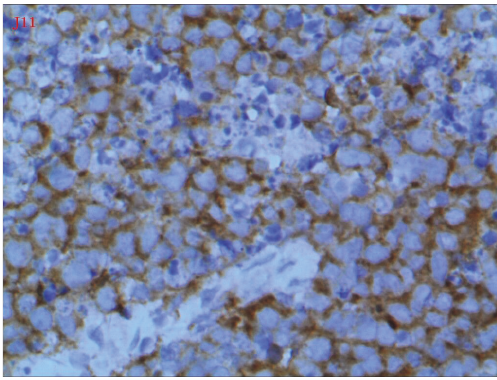
Figure 3: Histology of the cervical small cell carcinoma (X400). The H&E staining of the tissue section showed hypercellularity and the majority of the tumor cells were small and hyperchromatic and featured high nuclear cytoplasmic ratio. Figure 1: Pelvic MRI.